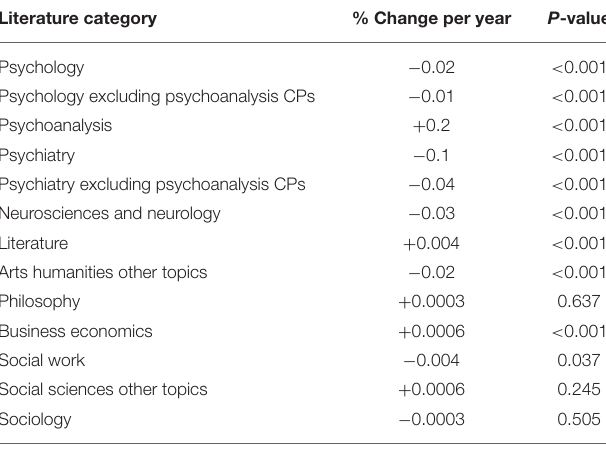
TABLE 2 | Trends in the percentage of literature citing Freud.